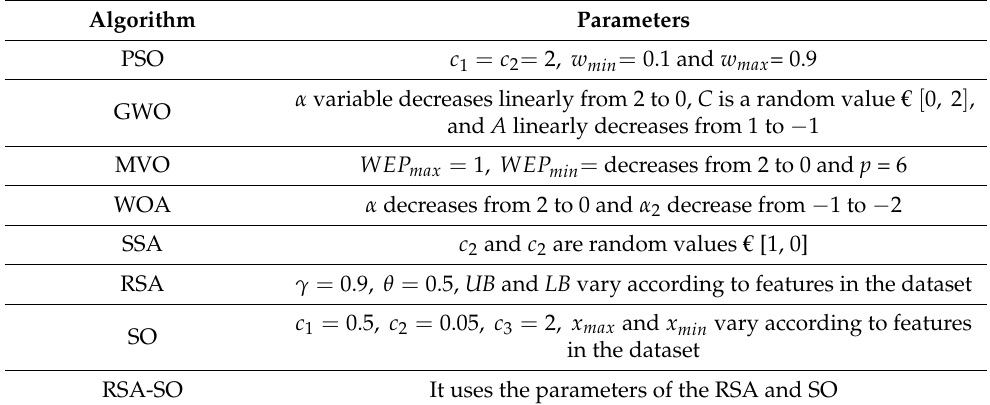
Table 2. Parameter